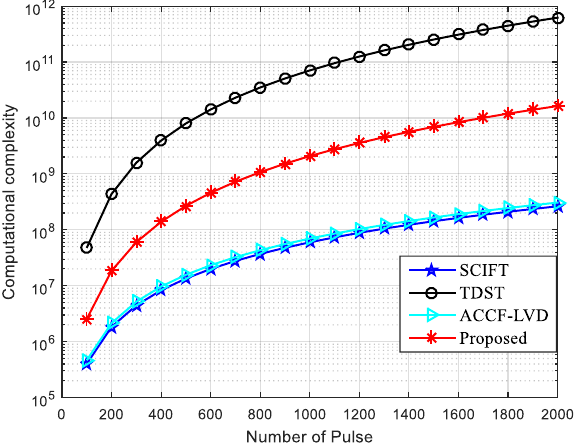
Figure 5. Computational complexity comparison.